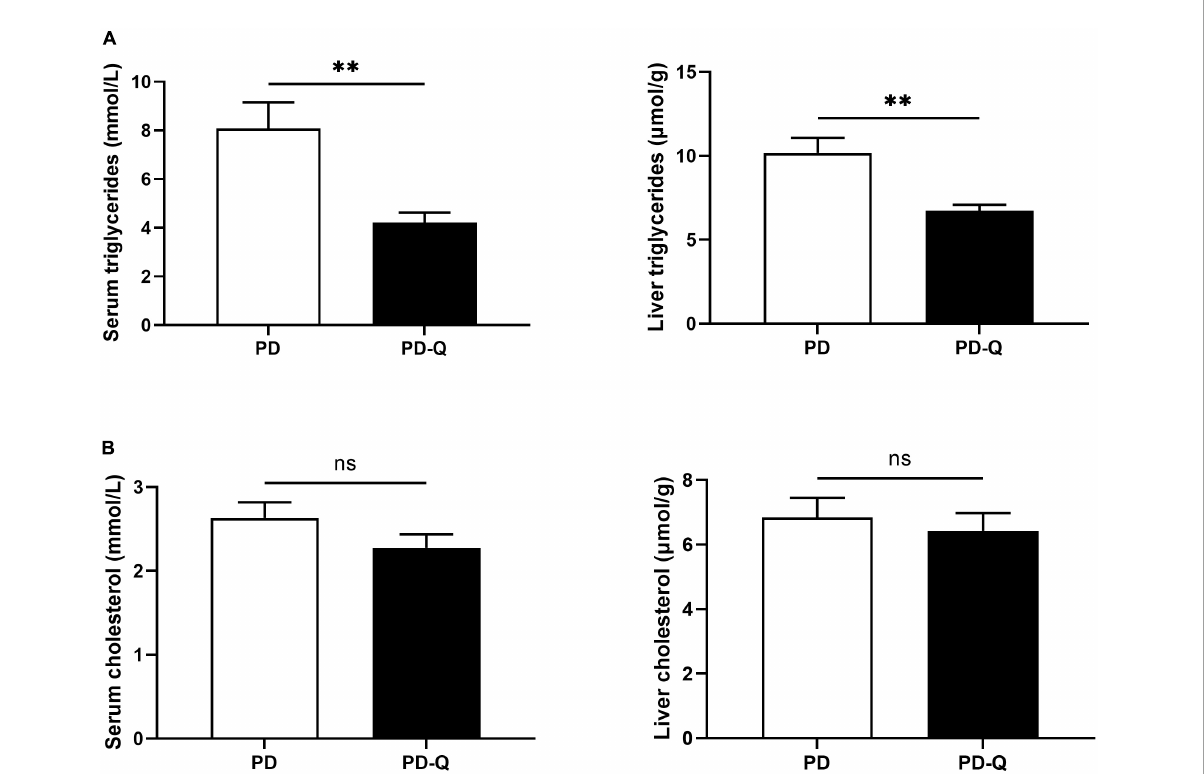
FIGURE3 Effect of quercetin supplementation on the triglycerides (A) and cholesterol (B) levels in the serum and the liver tissue. Values are mean ± SEM, n = 6/group, ** p < 0.01, ns, not significant. PD, control rats; PD-Q, rats supplemented with